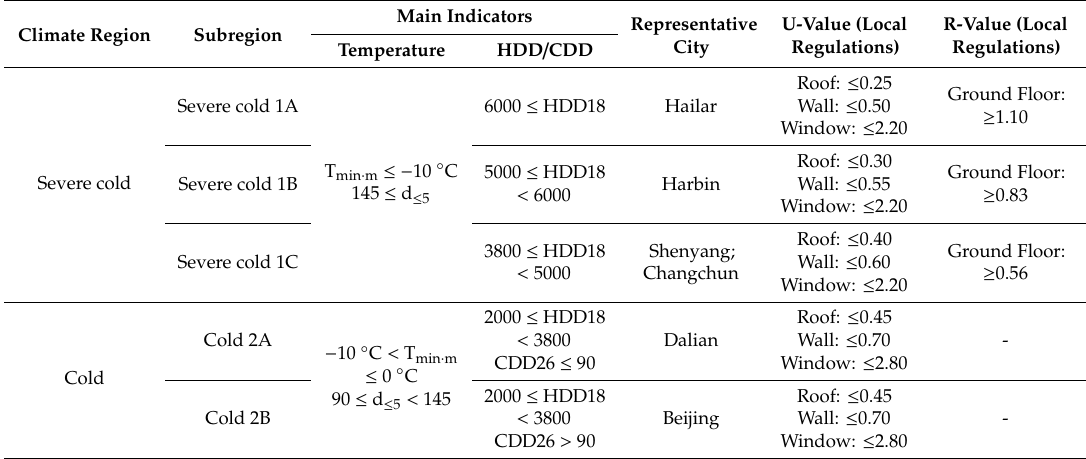
Table 3. Six case study cities by climate regions in China.